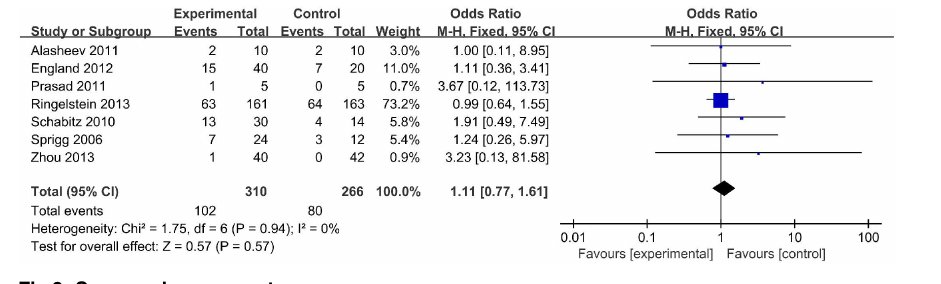
Fig 3. Severeadverseevents.